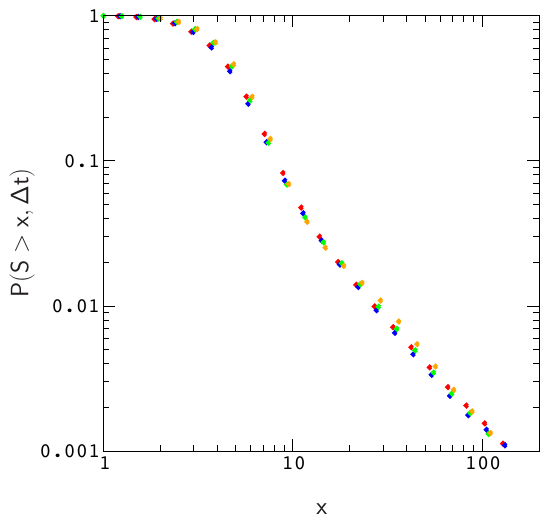
Figure 2. Probability, P ( S > x , ∆ t ) , that an allele, randomly sampled at time t , has crossed a valley of depth S = 2 Ns in the interval [ t − ∆ t , t ] for ∆ t = 128 N and µ N = 1. The data describe the same model as in Figure 1. Plots for population sizes N = 100, 200, 500, and 1000 are colored red, blue, green, and orange,